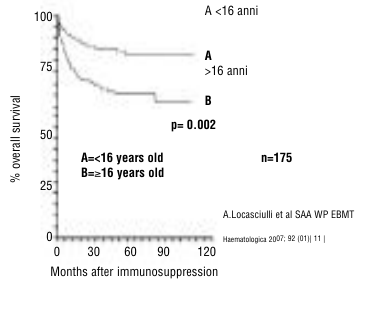
Figura 1. Outline del protocollo di immu - no soppressione di prima linea per AAA.